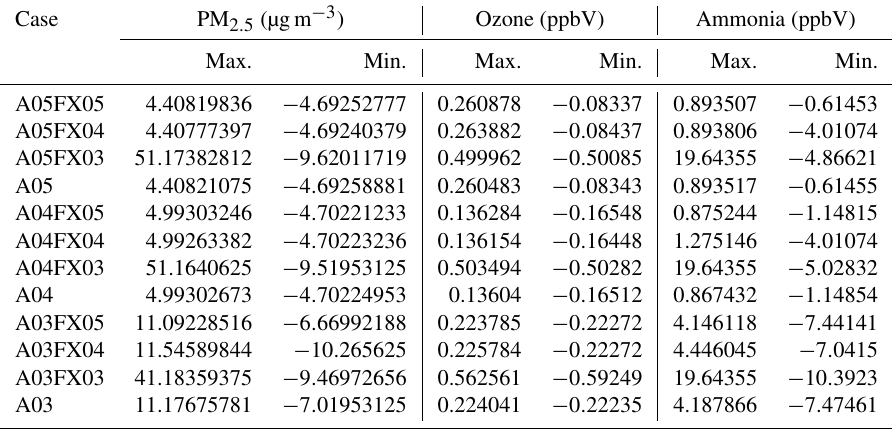
Table 4. Maximum and minimum biases (altered – orig) calculated from hourly CMAQ output for all simulations and cases with respect to the orig simulation across all grid